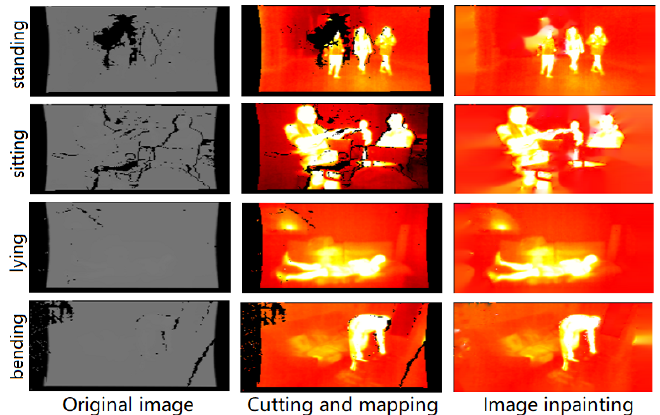
Figure 3. An illustration of the visualization results before and after image processing. The left column shows the original input images, the middle column shows the images after cutting and mapping, and the right column shows the images after image inpainting.